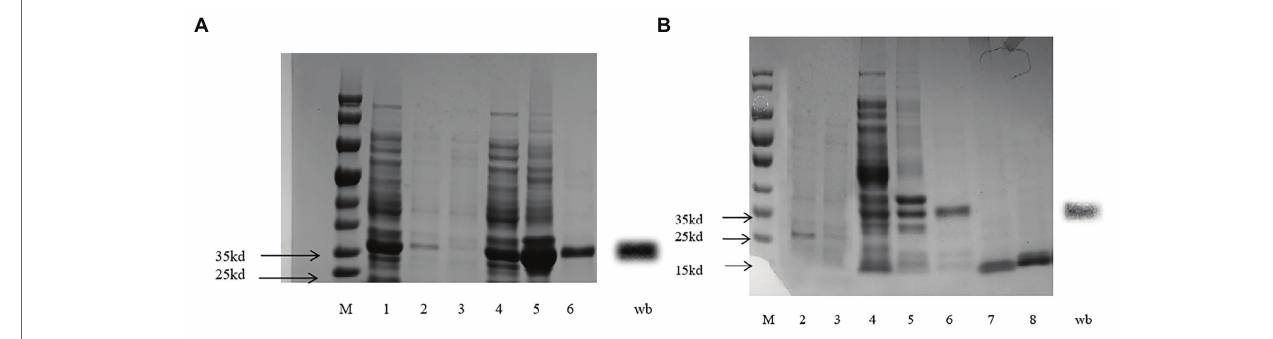
FIGURE 8 | SDS-PAGE for recombined CpunPBP5 (A) and CpunOBP2 (B) .